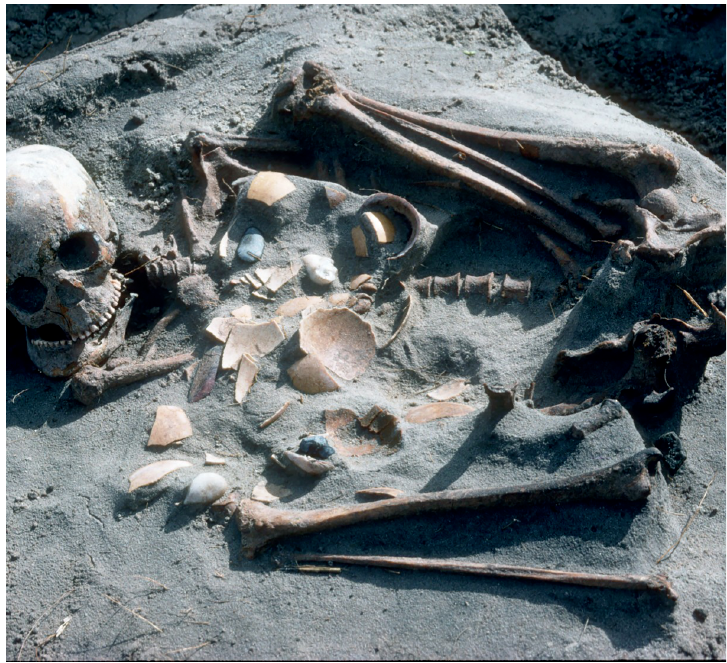
Fig 3. Field photograph (early 1990s) of exposed surface of “1997 unit”. Artifacts are clearly visible. Credit: G. Avery.